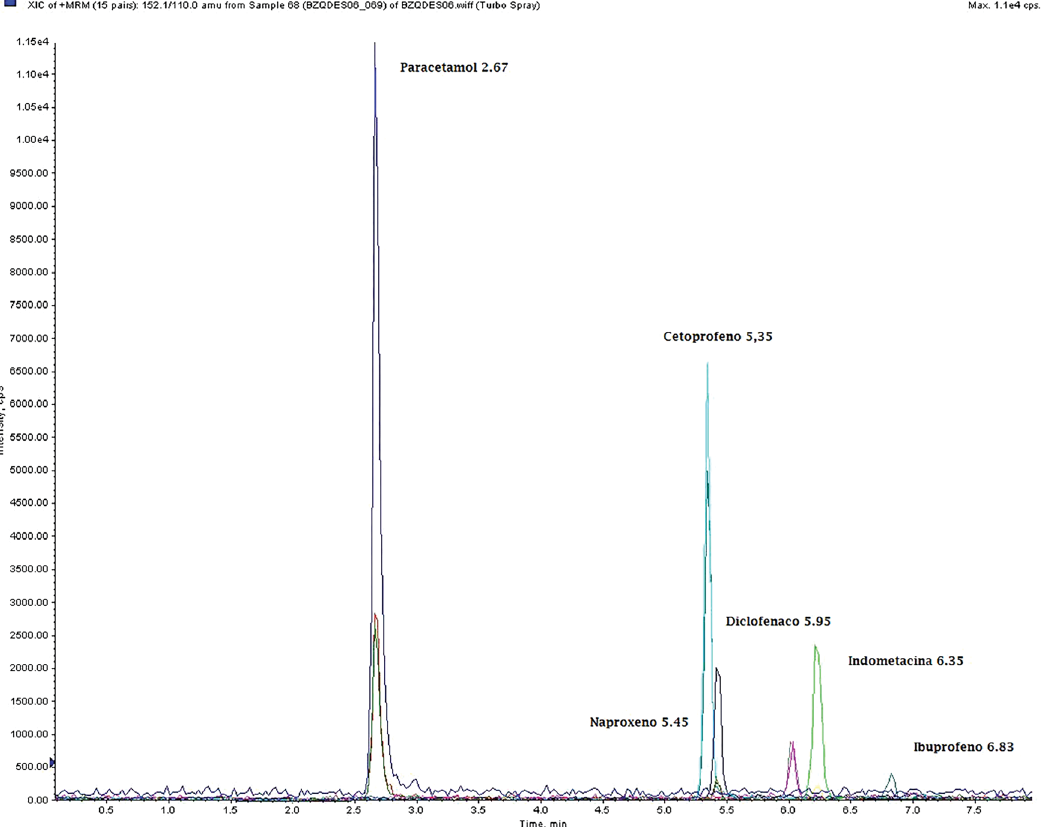
FIGURE 1 - Validation of the method: Chromatogram of drugs: acetaminophen, diclofenac, naproxen, ketoprofen, indomethacin and